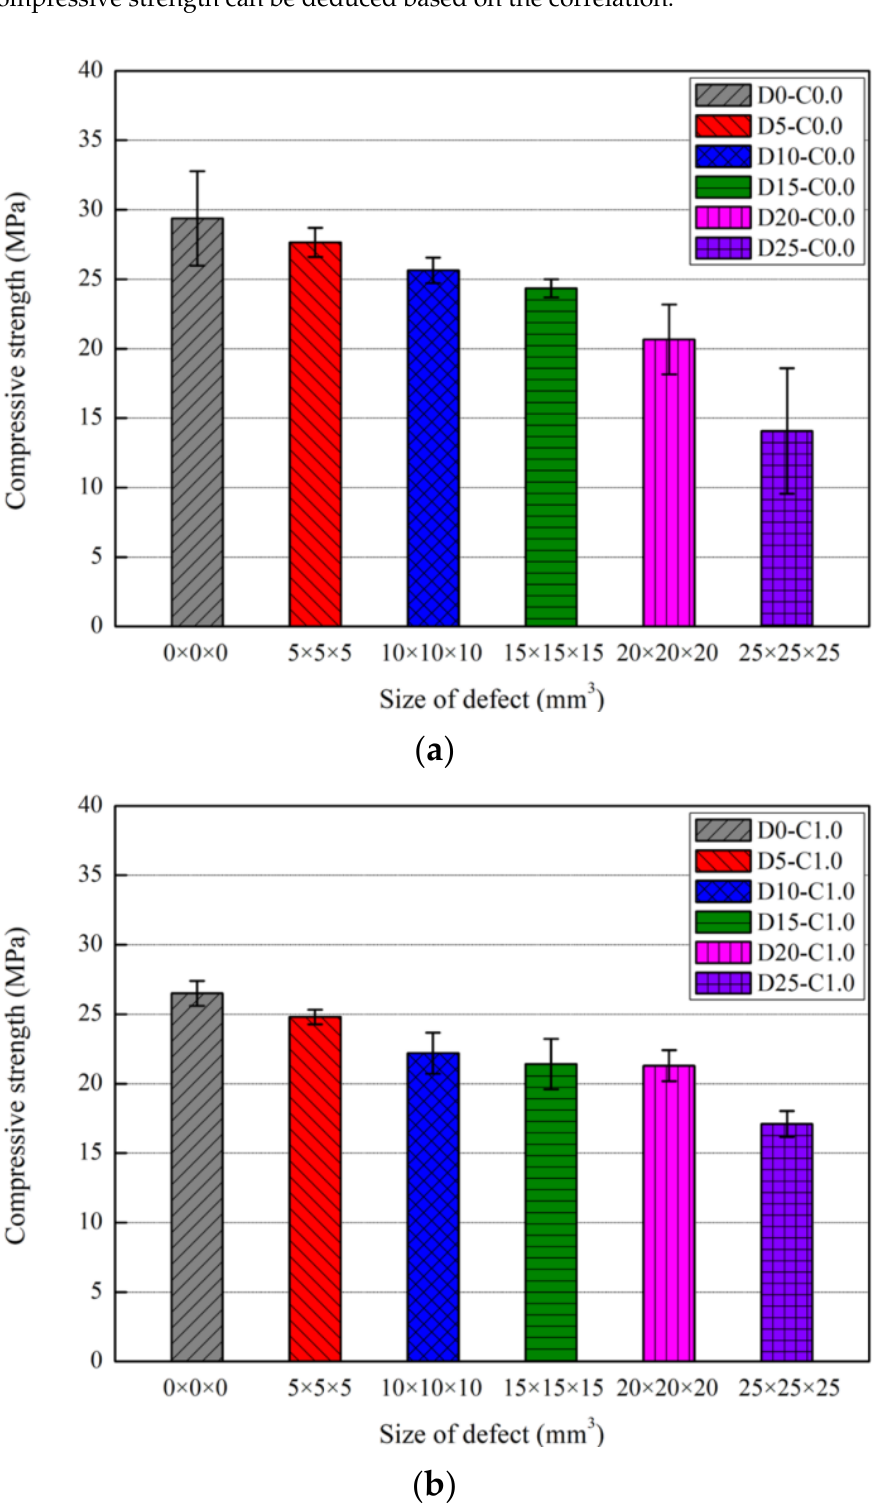
Figure 9. Compressive strength according to defect size: ( a ) MWCNT 0.0 wt%; ( b ) MWCNT 1.0 wt%. Table 3. Compressive strength of nano-cementitious composite on 30 curing days.